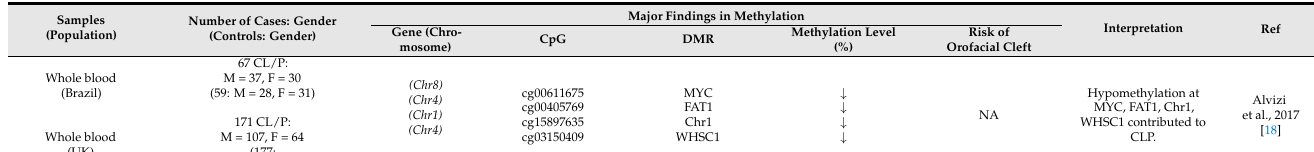
Methylationlevel associatedwith orofacialcleftsubtype, mostlyCPO,was NA hypermethylatedtoa greaterextentthanCLO (dependentonregions ofmethylation).